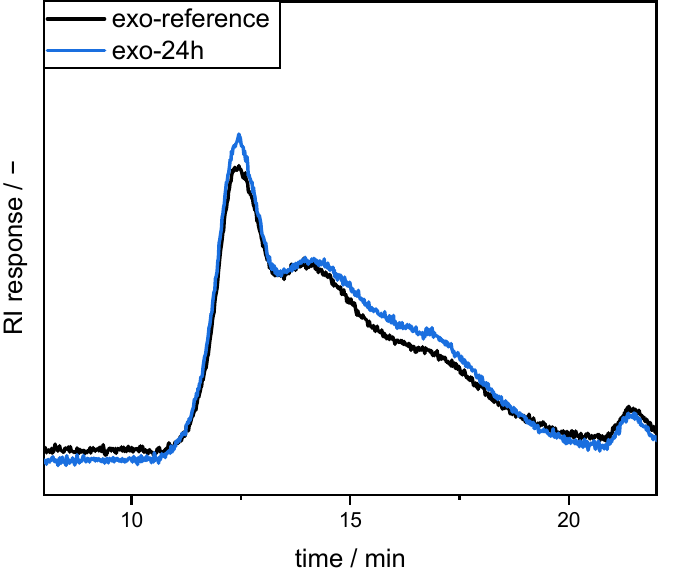
Figure 7. Elution patterns of the high performance size exclusion chromatography coupled with refractive index detection (HPSEC-RI) of the reference pectin (exo-reference) and the enzymatically modified pectin (exo-24h).